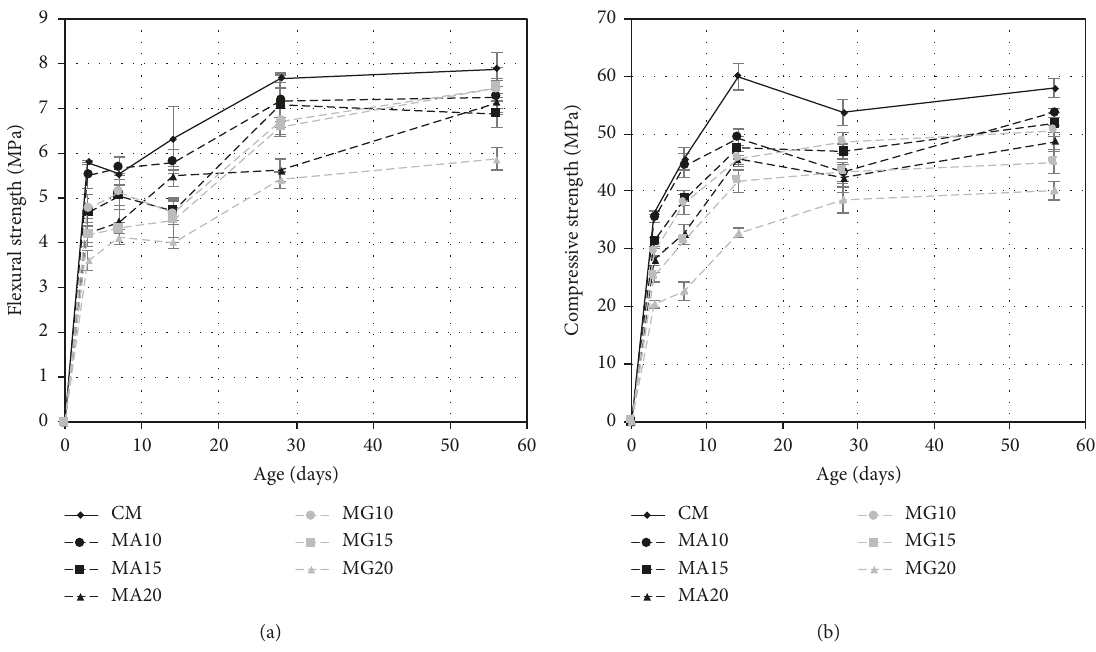
Figure 7: Flexural (a) and compressive (b) strength of mortars (CM: control mortar; MA: mortars with MgO A; MG: mortars with MgO G).